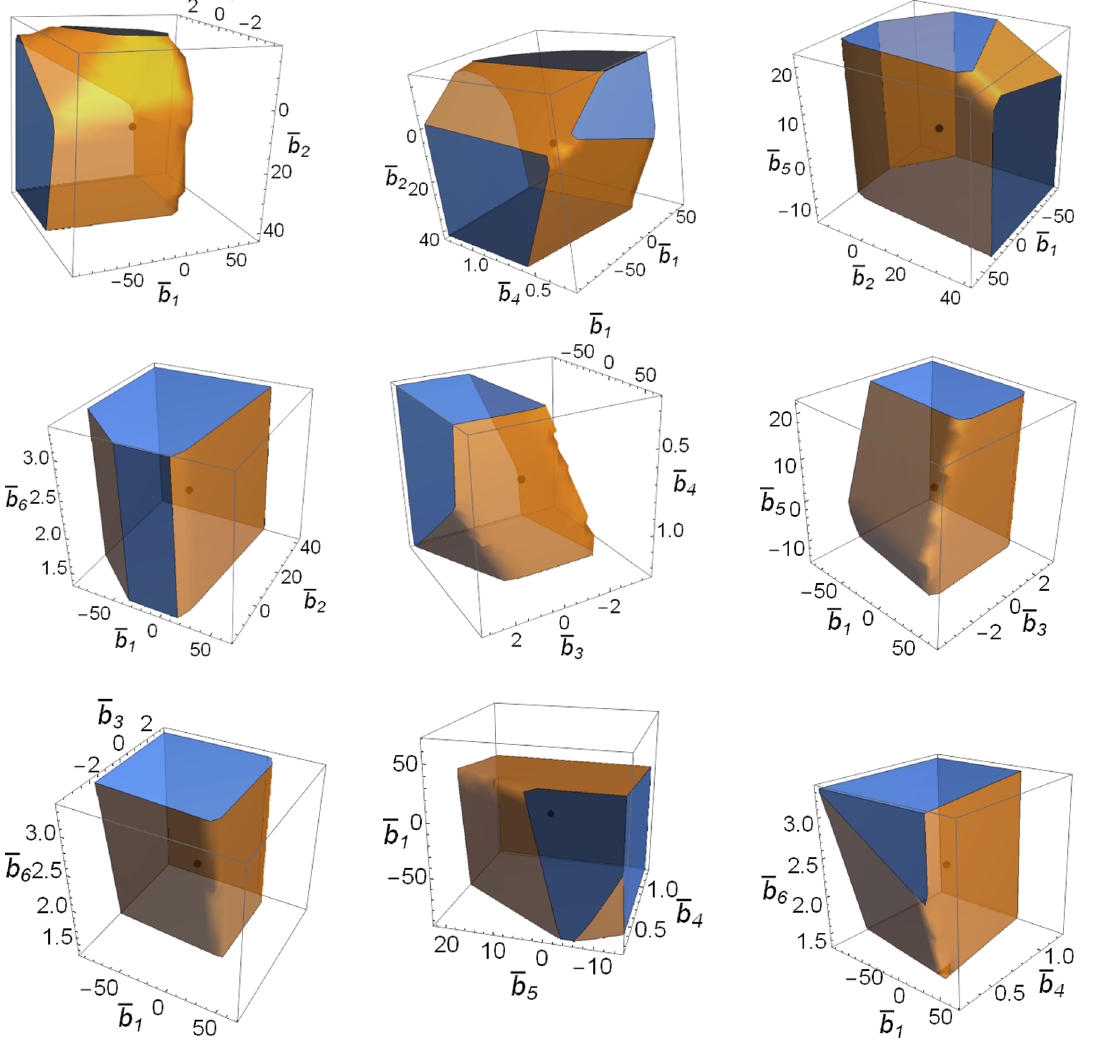
Figure 14 . 3D sections of the constrained b i space. The 3D sections are obtained by setting the other 3 parameters to the central values of the (cid:12)t (4.12). The black point represents the central values of the (cid:12)t (4.12) with inputs from the experimental data and theoretical estimates. To be continued in (cid:12)gure 15.